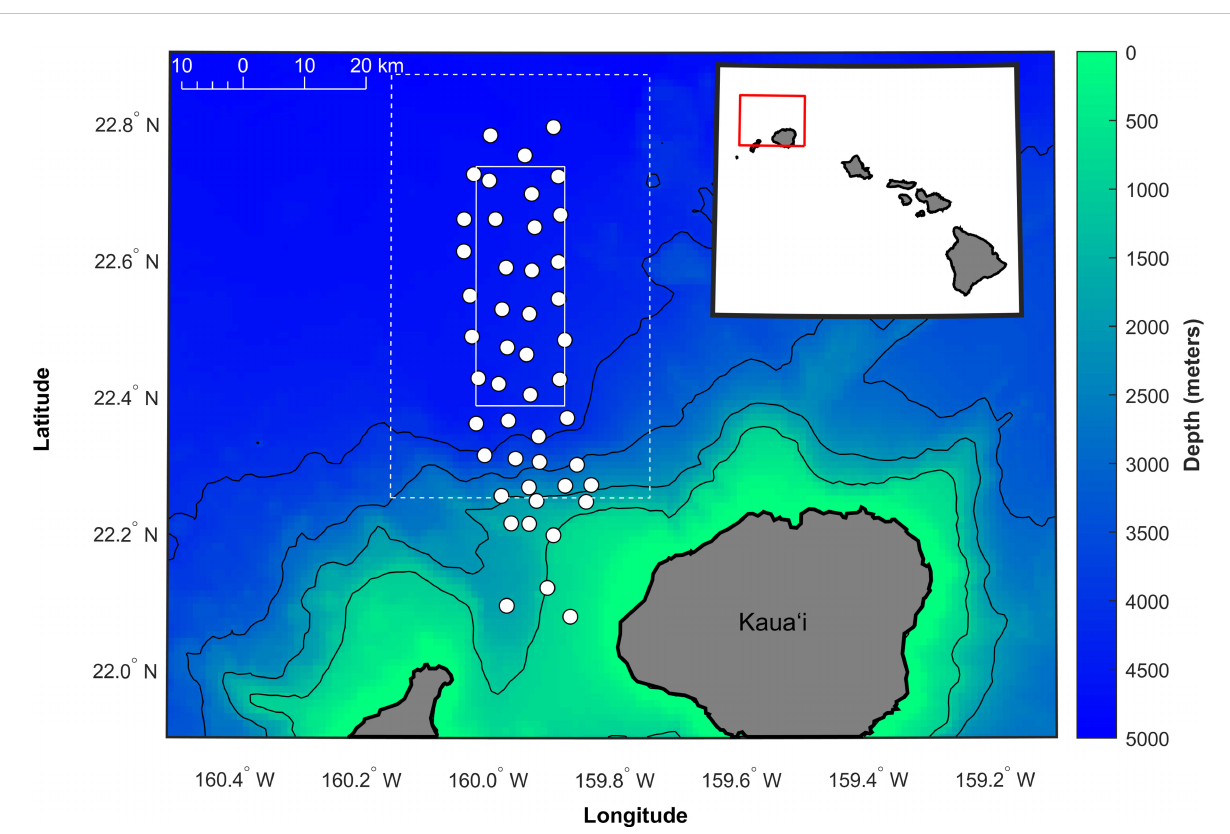
FIGURE 1 Map of the approximate locations of the 47 hydrophones used in this analysis (white circles) at the Paci fi c Missile Range Facility (PMRF) off Kaua ‘ i, Hawai ‘ i, as shown by the red box in the inset map. The focal study area of the array extends approximately 16 km to the east-west and 39 km to the north-south (boundaries shown by solid white box). The total study area extends 15 km outside the focal area and is shown with a dashed white box. Depth contours are every 1,000 m (1 km spatial resolution, Hawai ‘ i Mapping Research Group, The School of Ocean and Earth Science